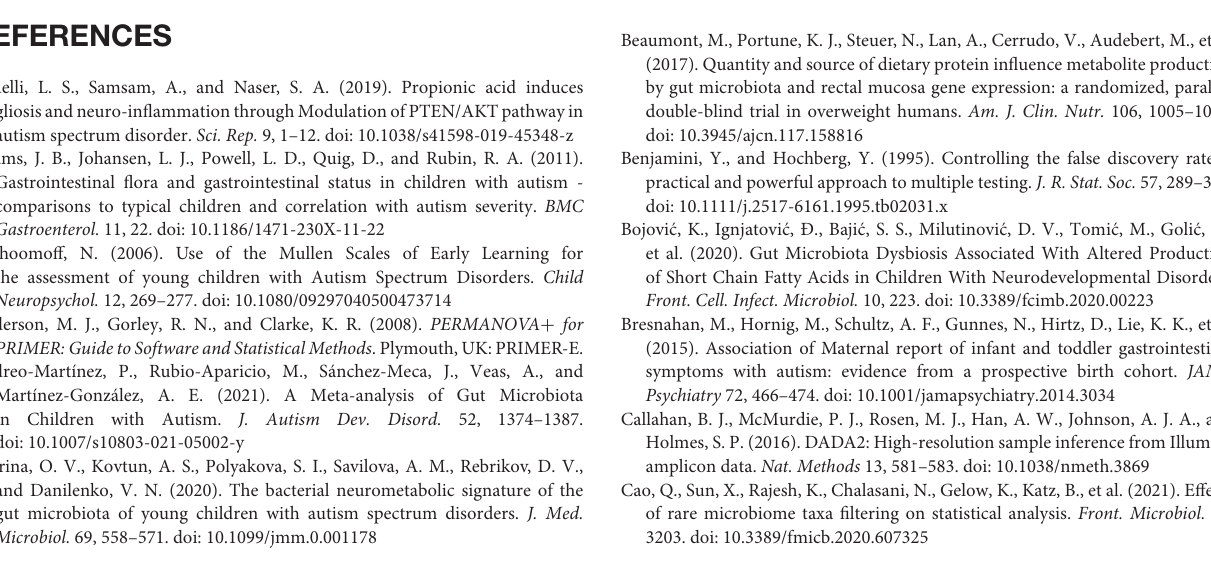
https://figshare.com/s/